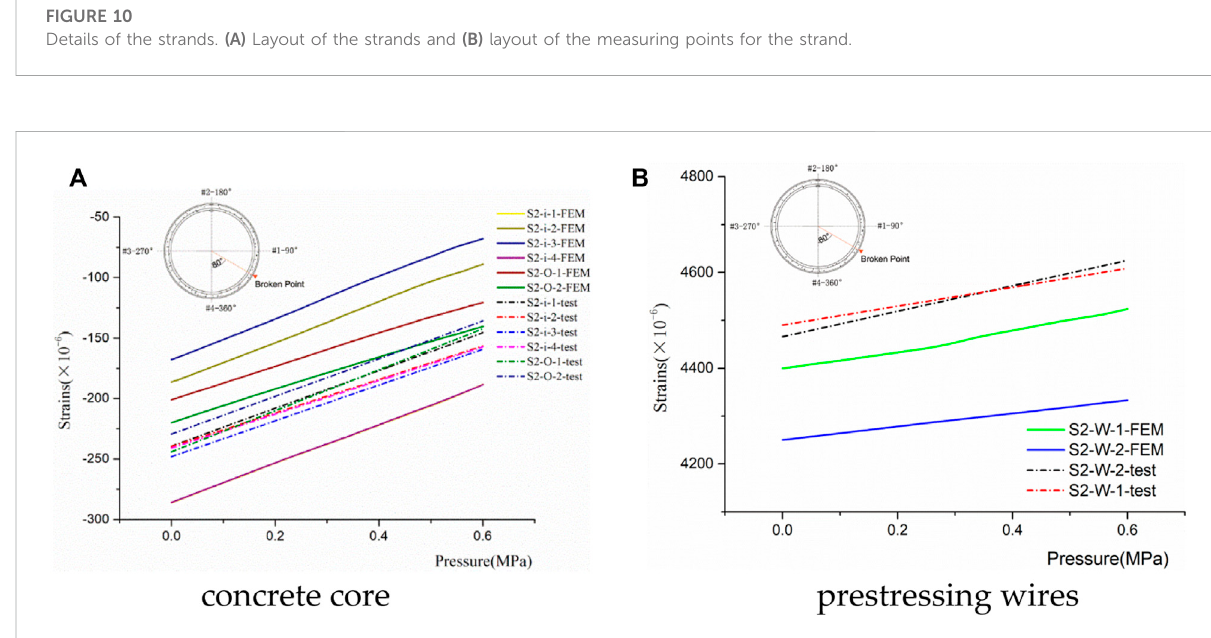
FIGURE 11 Comparison of FEM and test results of the concrete core at load stage I. (A) Concrete core and (B) prestressing wires.